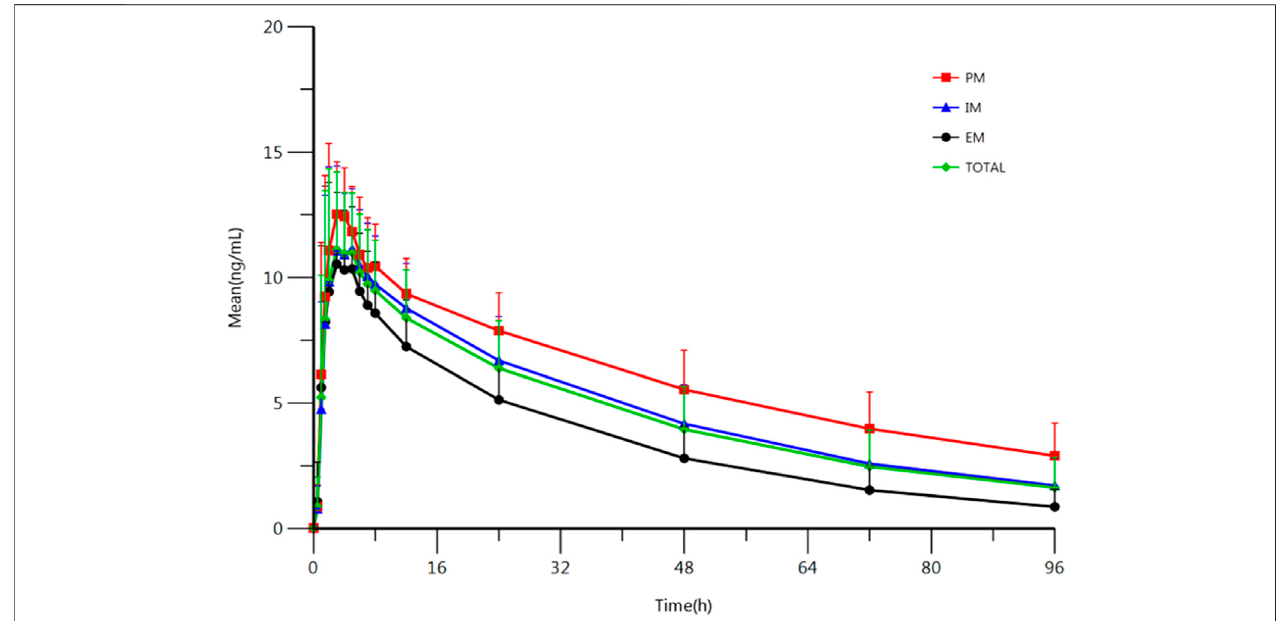
FIGURE 2 | Mean plasma concentration-time pro fi le of escitalopram after oral administration of 10 mg escitalopram tablet in IM ( n (cid:1) 47), PM ( n (cid:1) 27) and EM ( n (cid:1) 13), respectively. All values are presented as mean ± standard deviation.